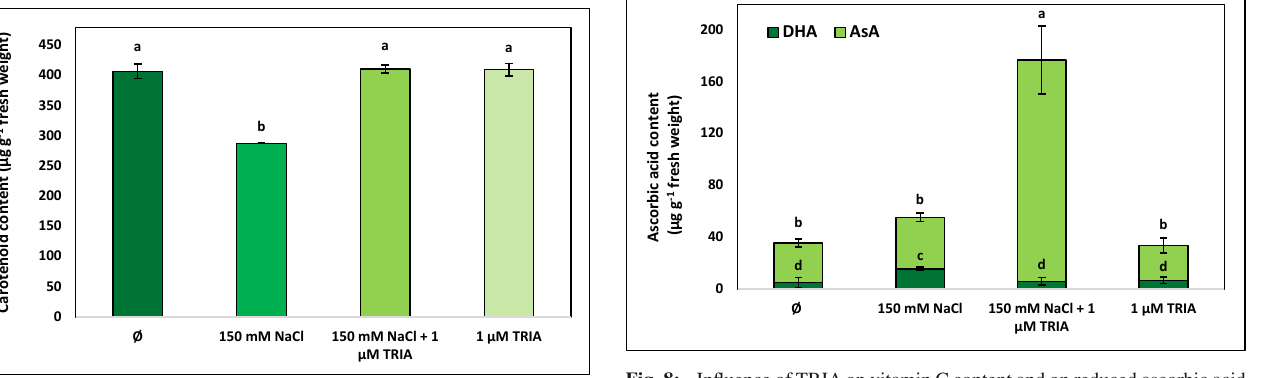
Fig. 7: Influence of triacontanol (TRIA) on carotenoid pigment content in leaves of spinach exposed to 150 mM NaCl. Ø stands for the con- trol group. Vertical bars represent ± standard error from means (n=5), different letters above the columns indicate significant differences at P < 0.05 (Tukey’s HSD